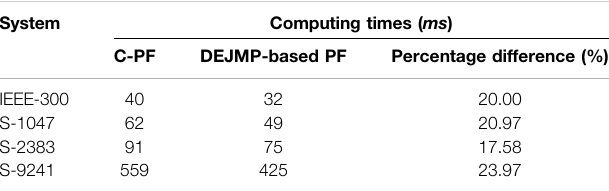
TABLE 1 | Computing times of PF.